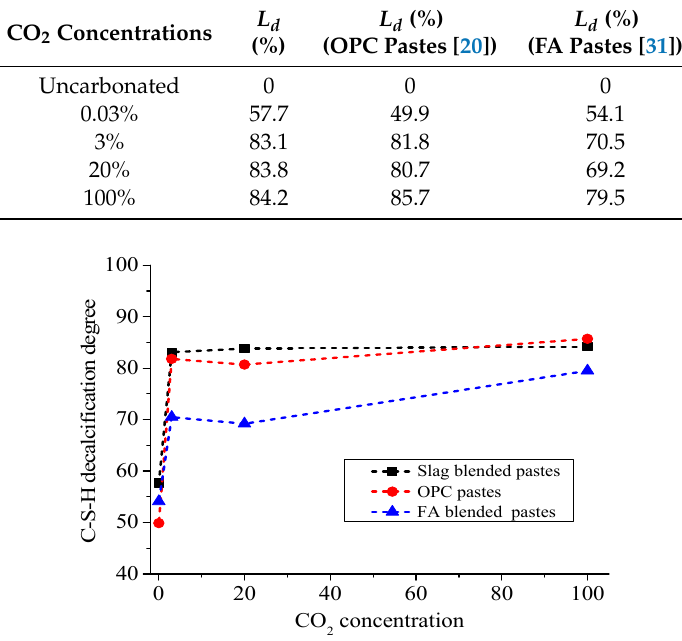
Figure 5. Evolution of C-S-H decalcification with the improvement in CO 2 concentration.